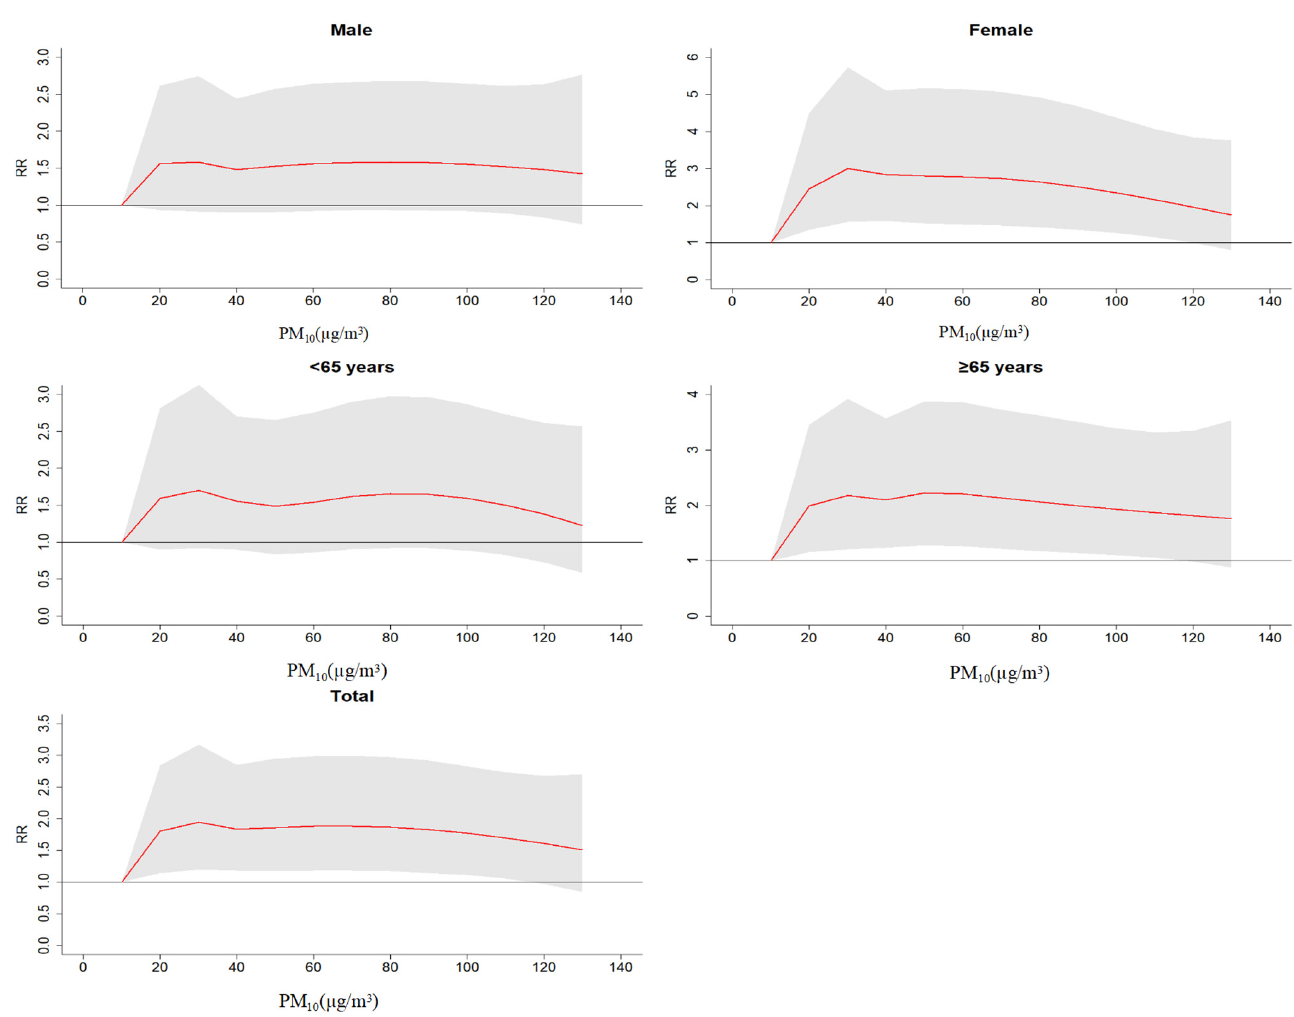
Figure 1. Relative risk (RR) of CHD hospitalization caused by different PM 10 concentrations.